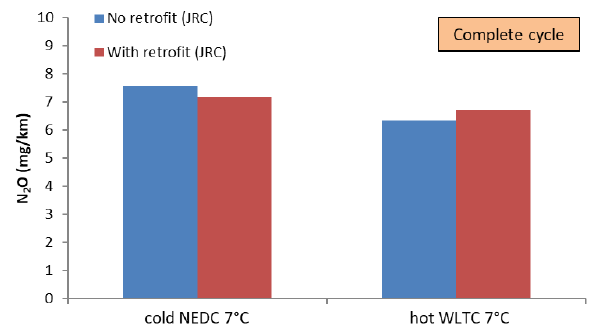
Fig. 5. N 2 O results for the complete cycles